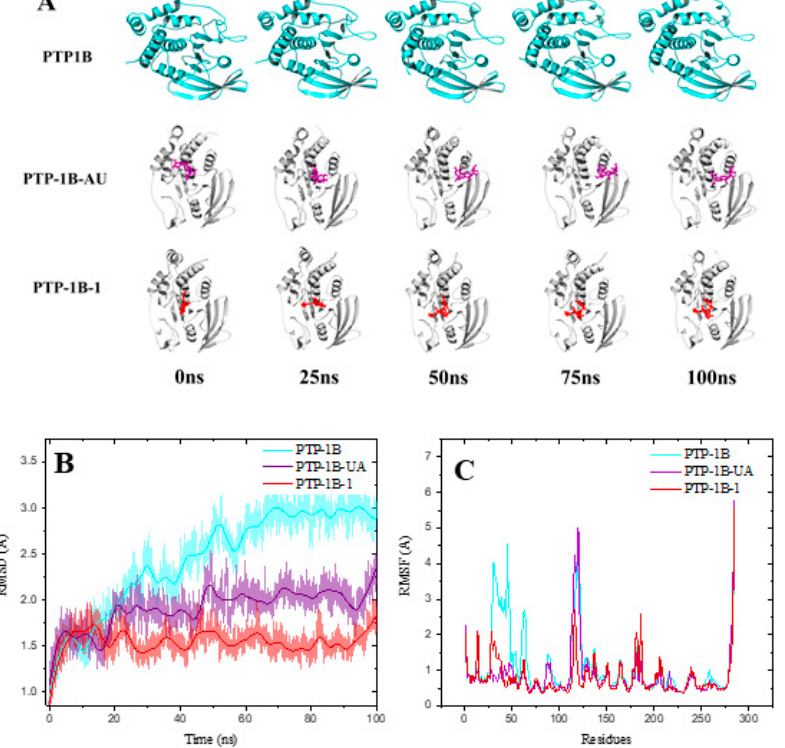
Figure 3. Molecular dynamics at the catalytic site of PTP-1B for compound 1 . ( A ) Structural models, ( B ) RMSD and ( C ) Root Mean Square Fluctuations (RMSF) from molecular trajectories. AU = UA